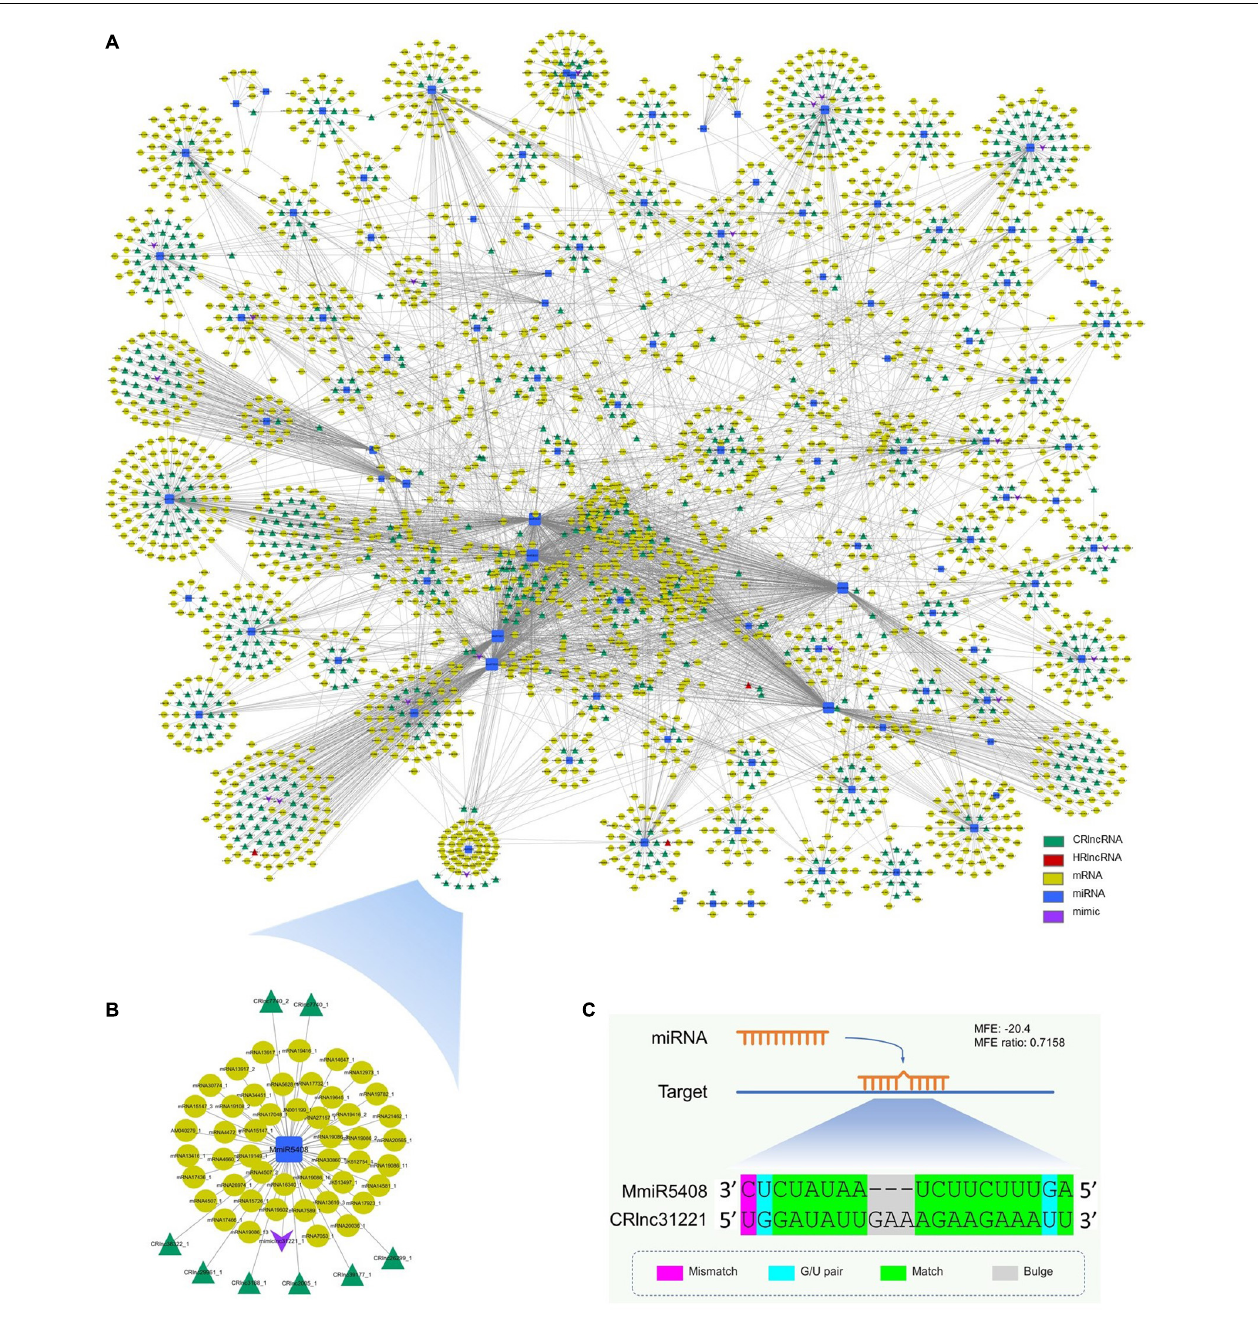
FIGURE 4 | Interaction network among mango ncRNAs and their targets; green triangles represent cold-responsive lncRNAs, red triangles represent heat-responsive lncRNAs, yellow ellipses are used for target genes, blue rectangles are for miRNAs, and purple V-shapes are for target mimics. (A) Network of interaction among newly identified miRNAs, newly identified lncRNAs (cold-responsive lncRNAs and heat-responsive lncRNAs), and newly identified target mimic of miRNAs and mRNAs; (B) subnetwork of interaction among MmiR5408, its target mimic CRlnc31221, target CRlncRNAs, and 47 target genes; (C) schematic diagram of the interaction between MmiR5408 and its target mimic cold-responsive lncRNA,